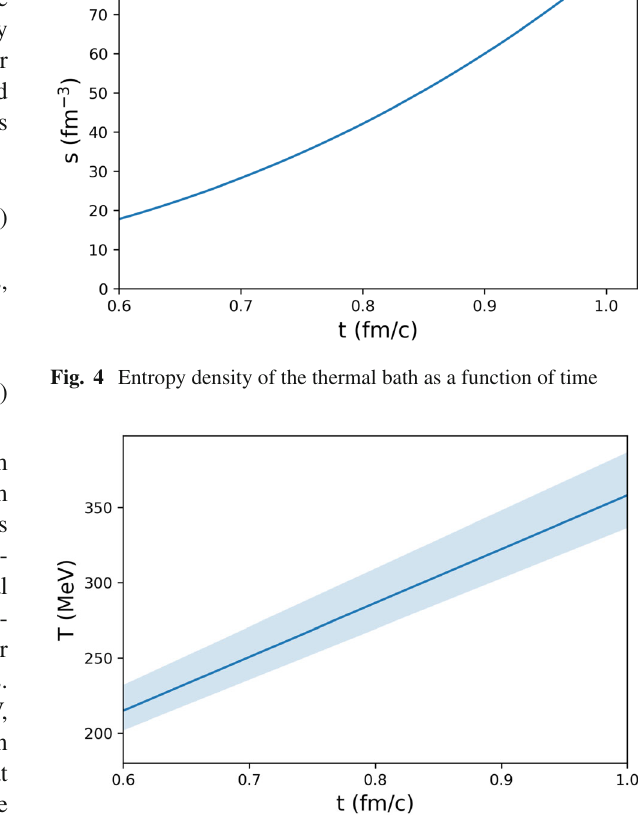
obtained a value of 15 < s dec < 20 fm − 3 for 0 < t < 2 fm/c, which is in agreement with our lower bound: from Eq. (19), s ( t o ) ≈ 10 fm − 3 for t o = 0 . 5 fm/c (from the simplified kernel), while s ( t o ) ≈ 5 fm − 3 for t o = 0 . 4 fm/c (when using the complete branching